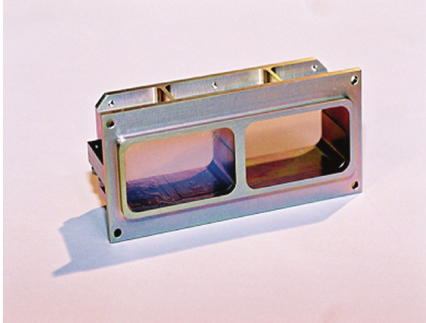
Figure 6: Two transparent silica aerogels fixed in an aluminum panel (CNES